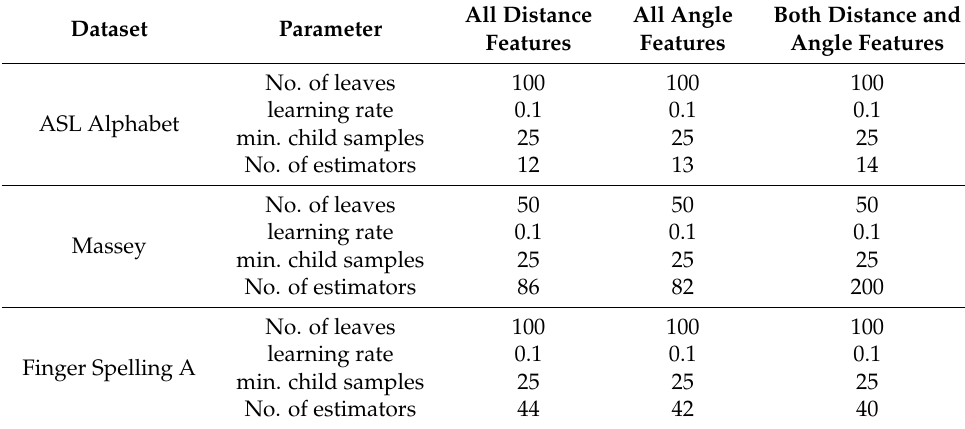
Table 7. Selected parameters of light GBM for different